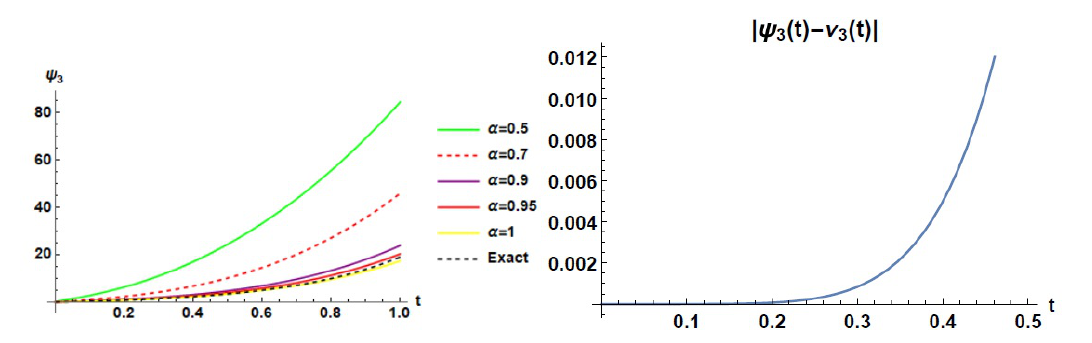
Figure 5: Exact, profile approximate solutions and absolute error regarding ν 3 of Example